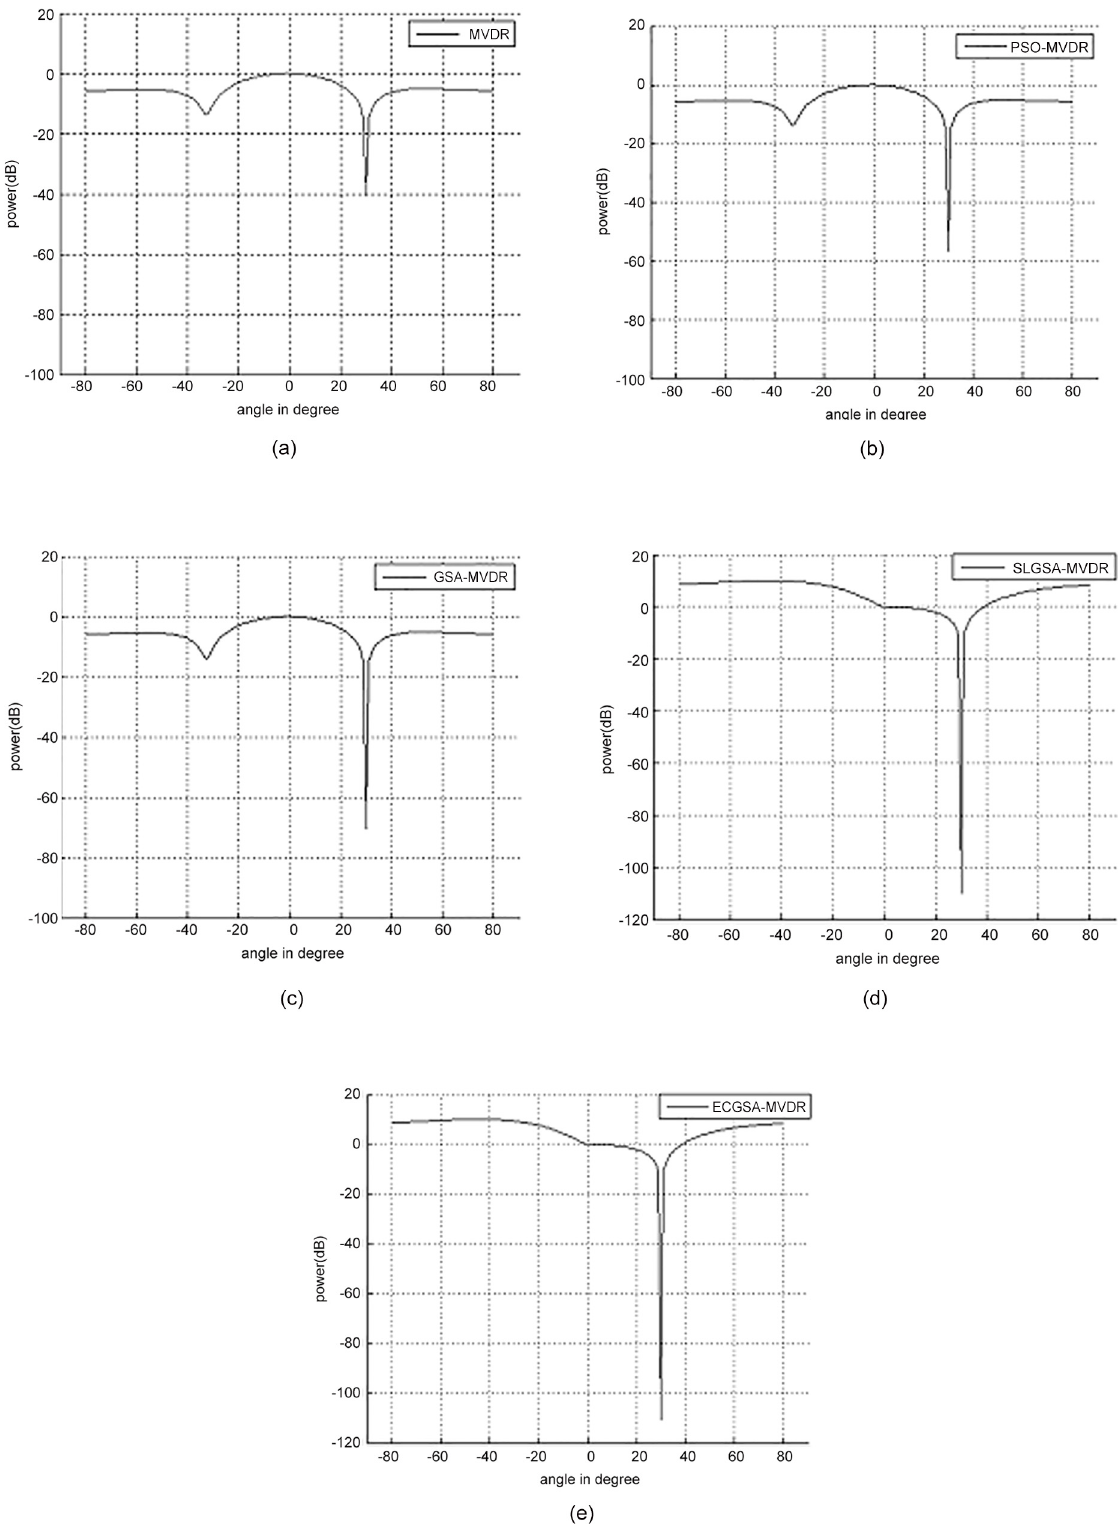
Fig 7. Comparison of performance of power response with 100 iterations for user at 0° with interference at 30°. (a) MVDR, (b) PSO-MVDR, (c) GSA-MVDR, (d) SLGSA-MVDR [28] and (e)